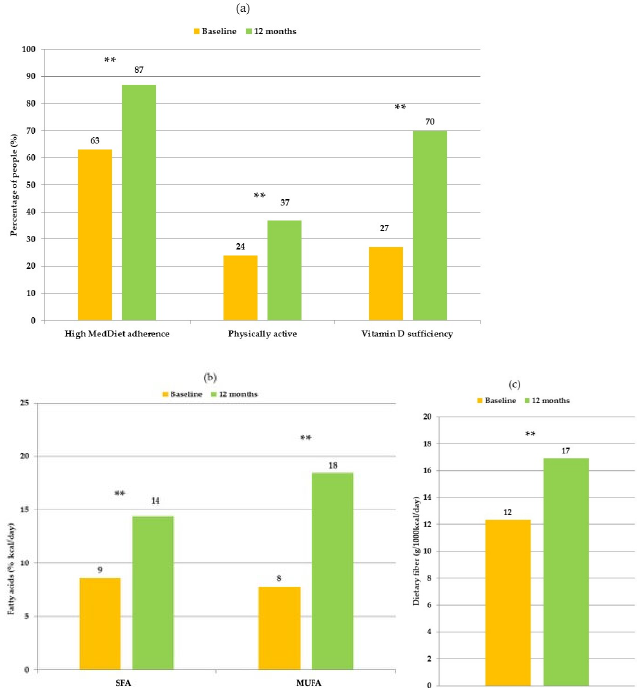
Figure 1. ( a ) Comparison of participants with high Mediterranean diet adherence (MEDAS score > 7), physically active (>7500 steps/day) and with vitamin D sufficiency ( ≥ 30 ng/mL) at baseline and at 12 months; ( b ) Comparison of participants’ fatty acids and ( c ) dietary fibers intakes at baseline and 12 months. (**) significance p < 0.001. In the EORTC QLQ ‐ C30 questionnaire, compared to baseline, at 12 months we ob ‐ served that patients had significantly higher scores for physical functioning ( p = 0.003), role functioning ( p = 0.002), and social functioning ( p < 0.001); among symptoms, at 12 months patients had significantly lower scores for fatigue ( p < 0.001), nausea and vomiting ( p = 0.015), dyspnea ( p = 0.001), constipation ( p = 0.049) and financial difficulties ( p = 0.012). At 12 months general global health status significantly increased ( p < 0.001) compared to baseline, indicating an improved HRQoL (Table 2, Figure 2). Pain symptom scores were also reduced at 12 months albeit not significantly ( p = 0.099). Table 2. Comparison of European Organization for Research and Treatment of Cancer Quality of Life Questionnaire Core 30 items (EORTC QLQ ‐ C30), Breast Cancer 23 items (EORTC QLQ ‐ BR23), and European Quality of Life 5 Dimensions 3 Level (EQ 5D 3L) scores of participants at baseline and at 12 months.